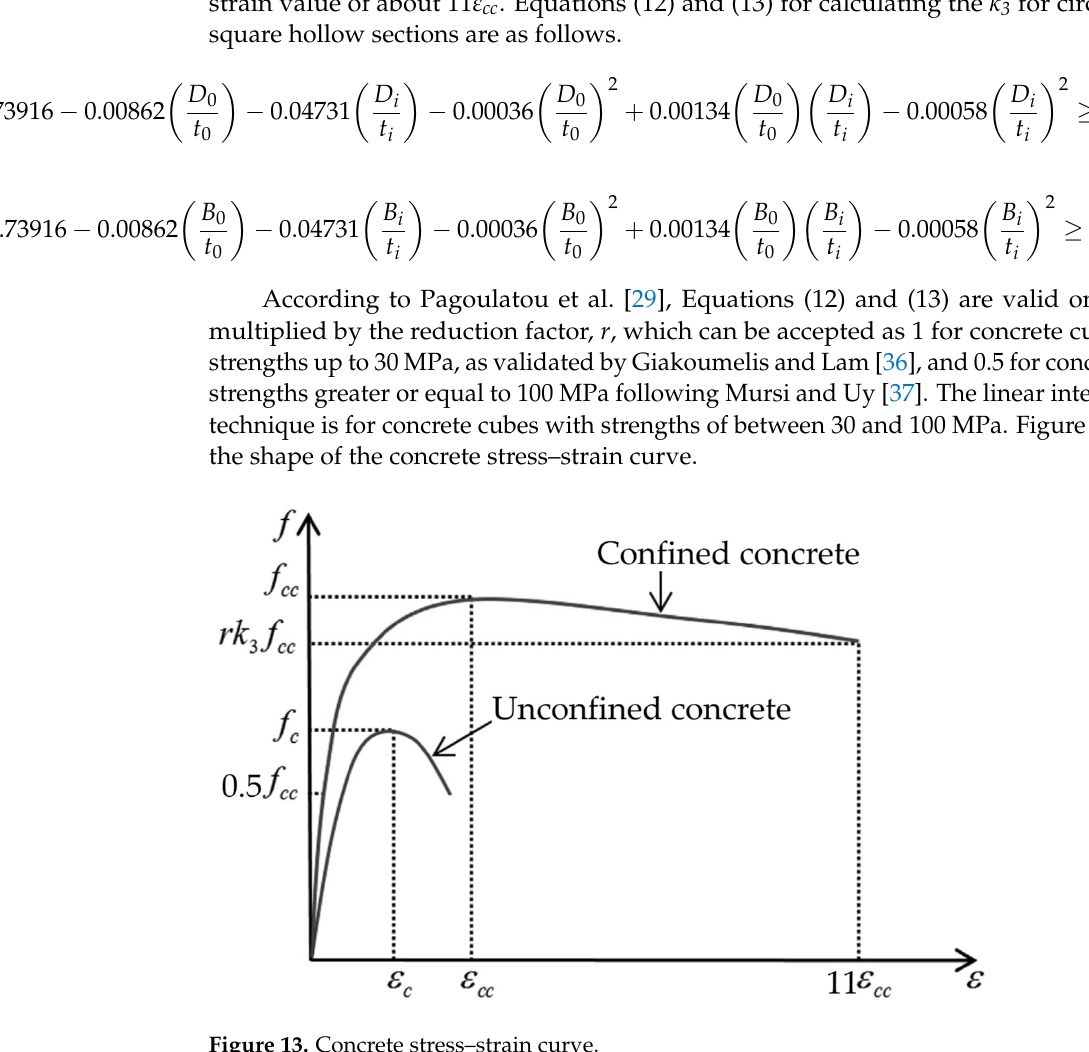
Figure 13. Concrete stress–strain